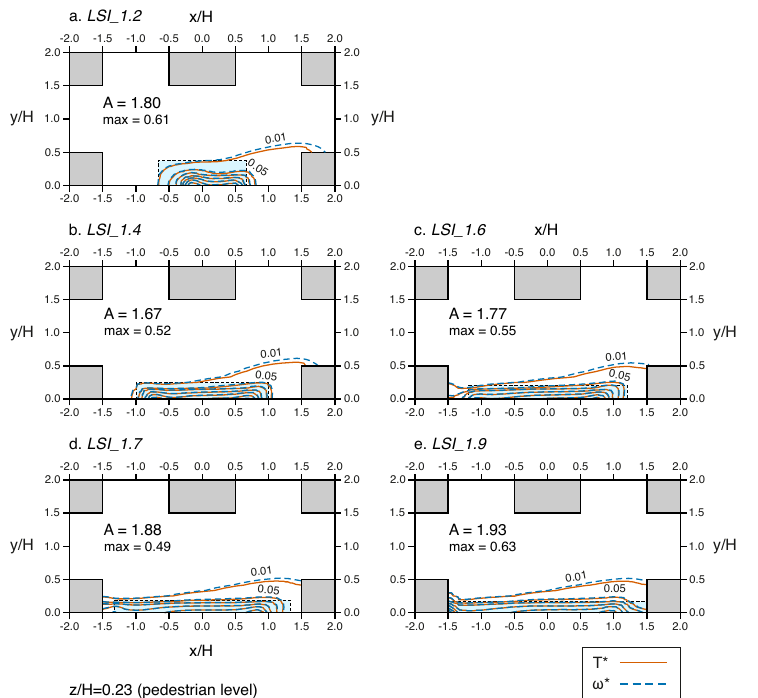
Figure 18. Contours of normalised temperature ( T ∗ ) and water vapour concentration ( ω ∗ ) over a vertical plane in the middle of the domain ( y / H = 0) for the warm water body cases ( ∆ T = + 2 K) and different shapes: ( a ) LSI_1.2 ; ( b ) LSI_1.4 ; ( c ) LSI_1.6 ; ( d ) LSI_1.7 ; ( e ) LSI_1.9 ; results of the original LSI = 1.1 case can be found in Figure 11a.